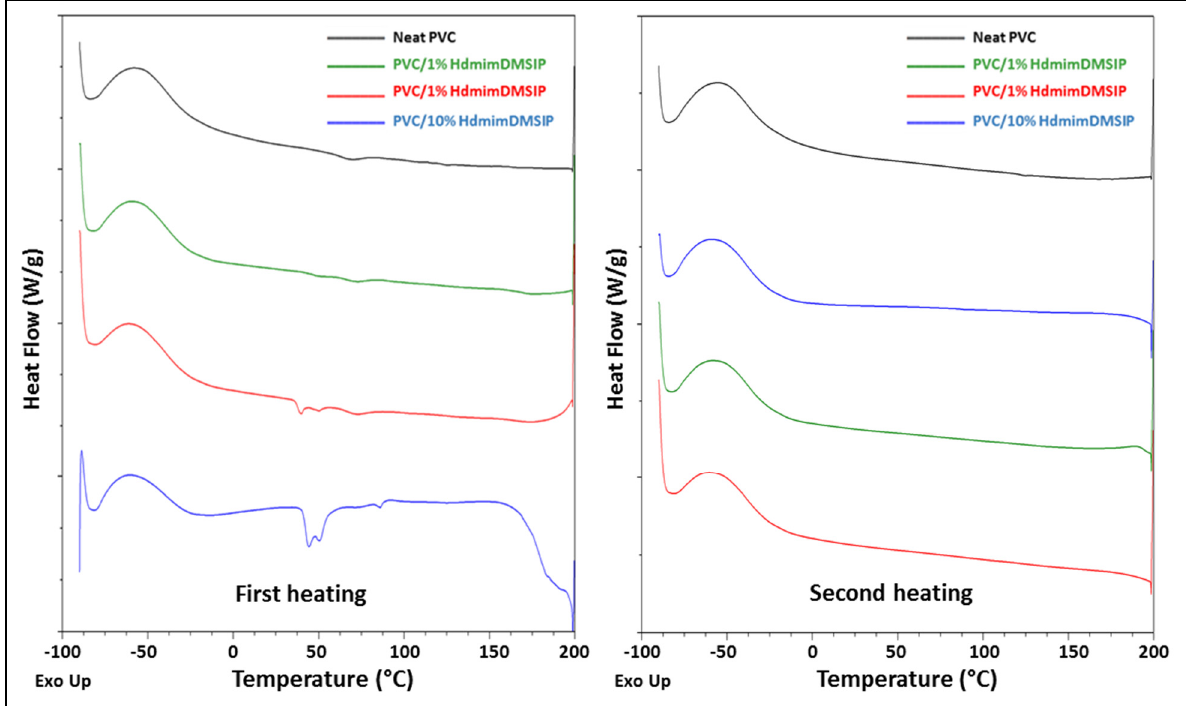
Figure 1. DSC curves of neat PVC and PVC/HdmimDMSIP blends. Curves are displaced for clarity.